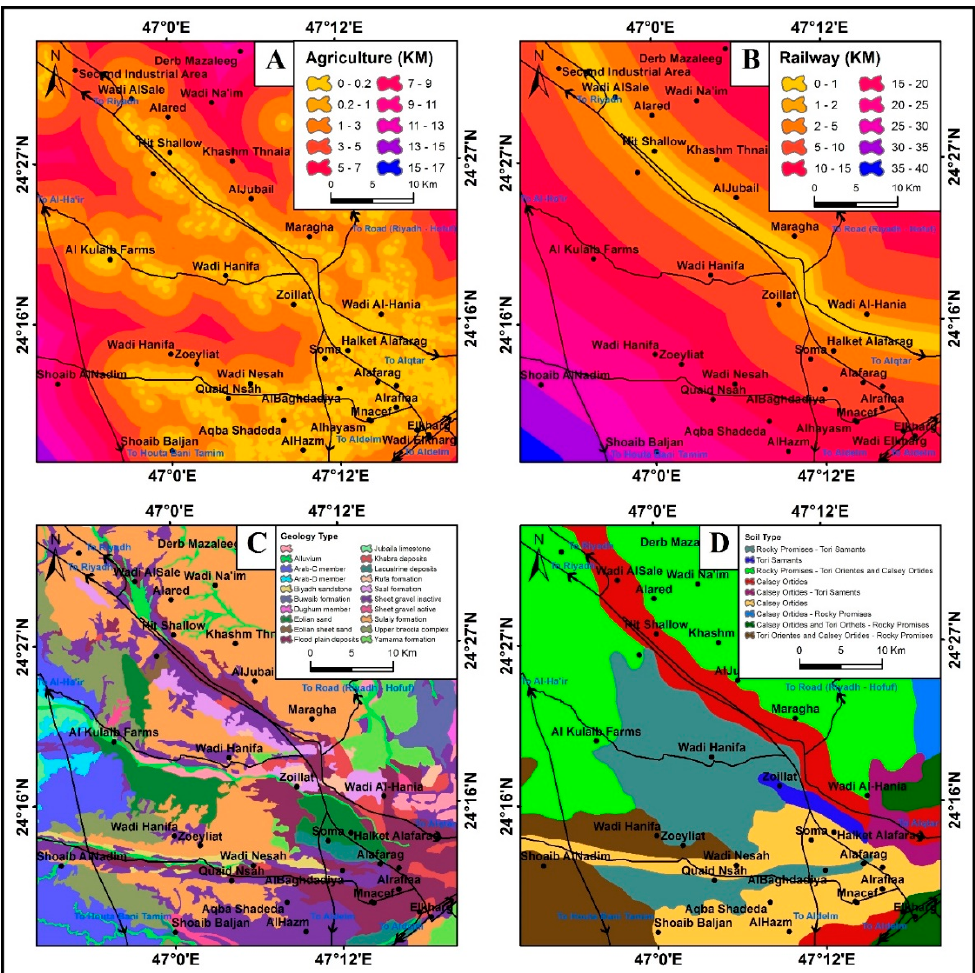
Figure 7. The distance ranges (part 2): ( A ) agriculture areas, ( B ) railways, ( C ) geology, ( D ) soil type.